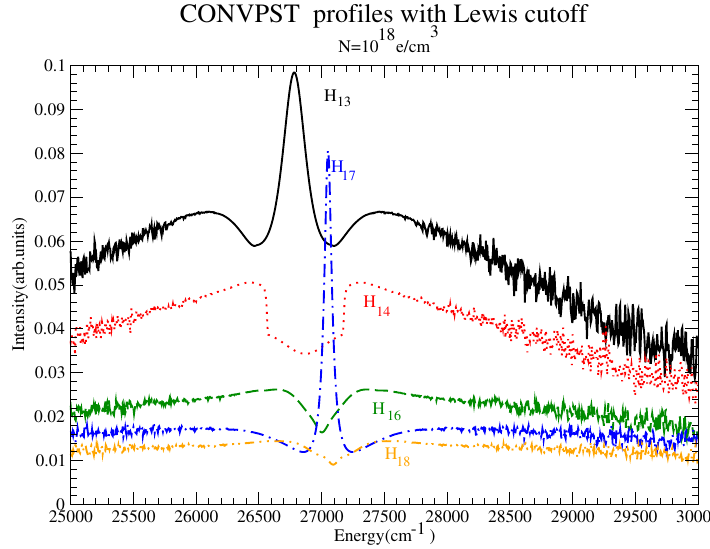
Figure 32. Intensity comparison for Balmer 13 to Balmer 18 at the intermediate density. Shown are CONVPST profiles for H 13 (solid black), H 14 (dotted red), H 16 (dashed green), H 17 (dash-dotted blue) and H 18 (dash-double dotted